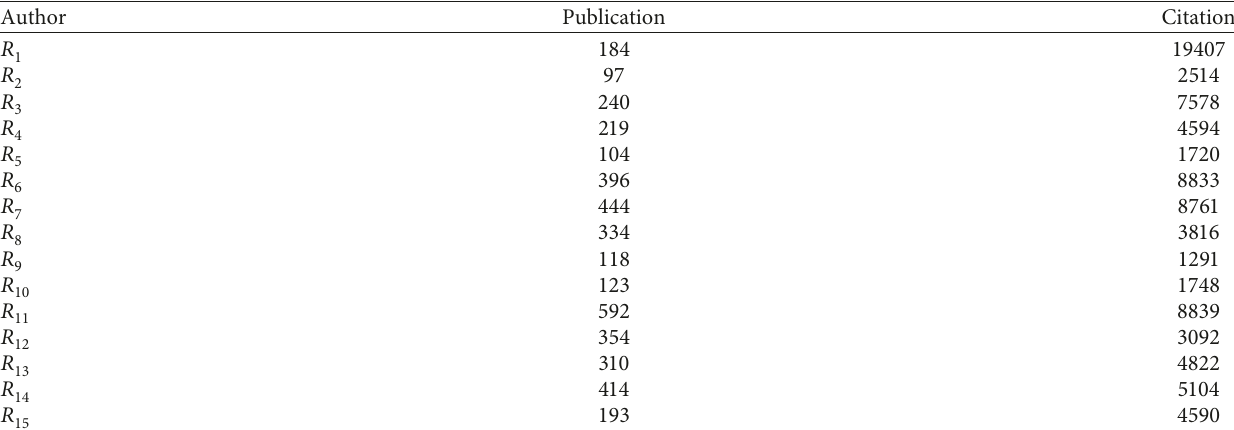
Table 2: Authors publications and citations since 1998 to 2016.